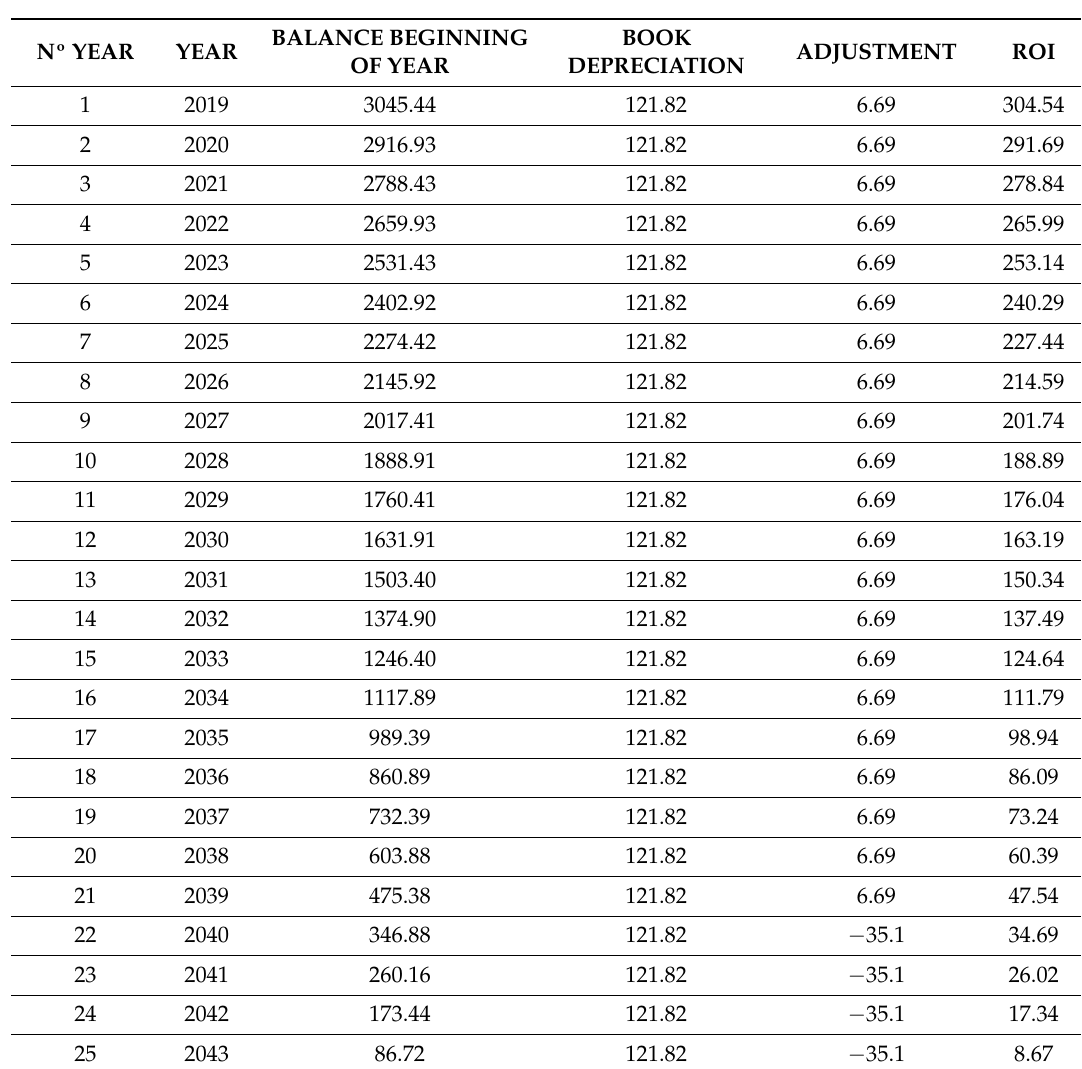
Table A4. Return of interests (ROI) on debt (65%) (in millions of